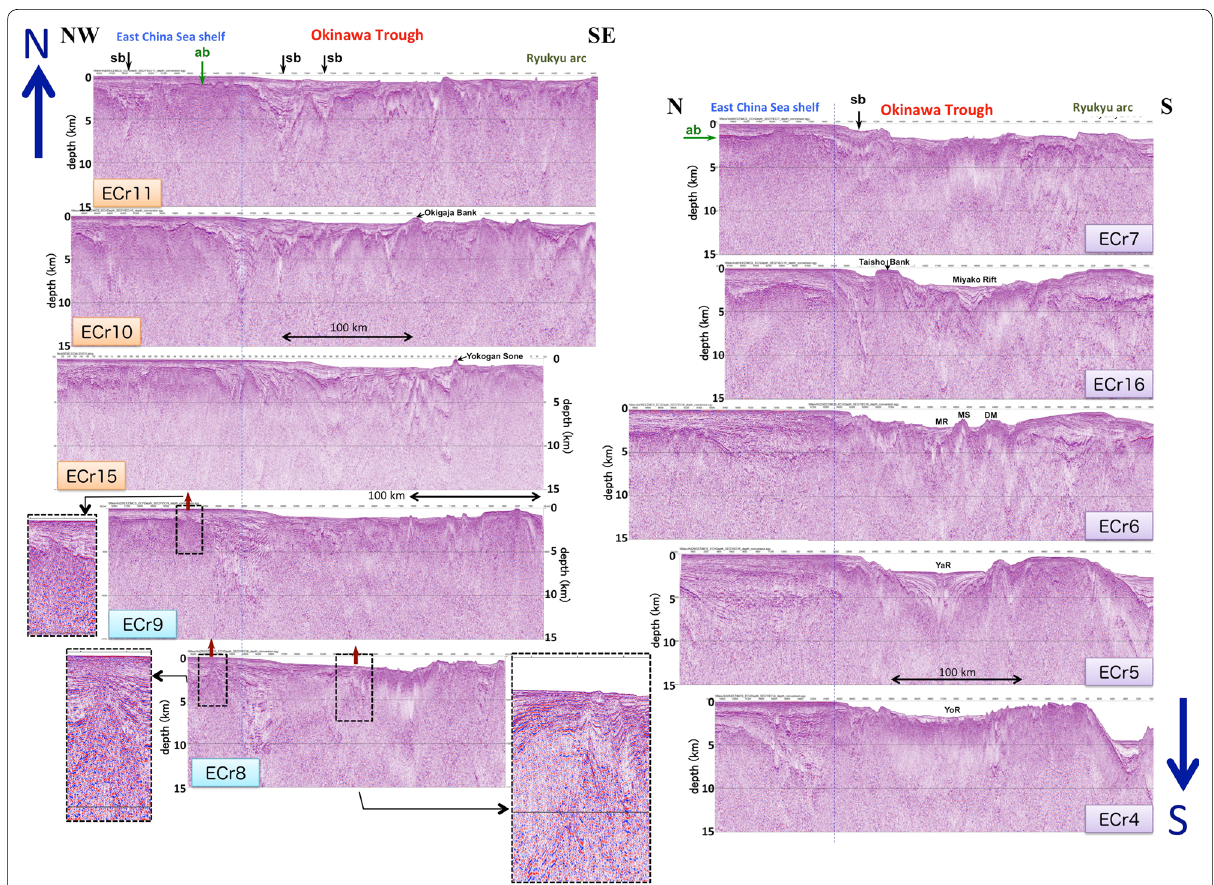
Fig. 4 Multichannel seismic profiles (MCS; depth-converted section) for the across-trough survey lines. These MCS sections were arranged from north to south and along the slope between the East China Sea (ECS) shelf and the OT. The vertical dashed blue line shows the position of the northwestern edge of the OT. Upward arrows on ECr8 and ECr9 indicate ascending high V p materials (in Fig. 5) in the top sedimentary layers. Blowups of the regions are also presented. DM Daiichi–Miyako Knoll, MS Miyako Seamount, YoR Yonaguni Rift, YaR Yaeyama Rift, MR Miyako Rift, sb sedimentary basin; ab acoustic